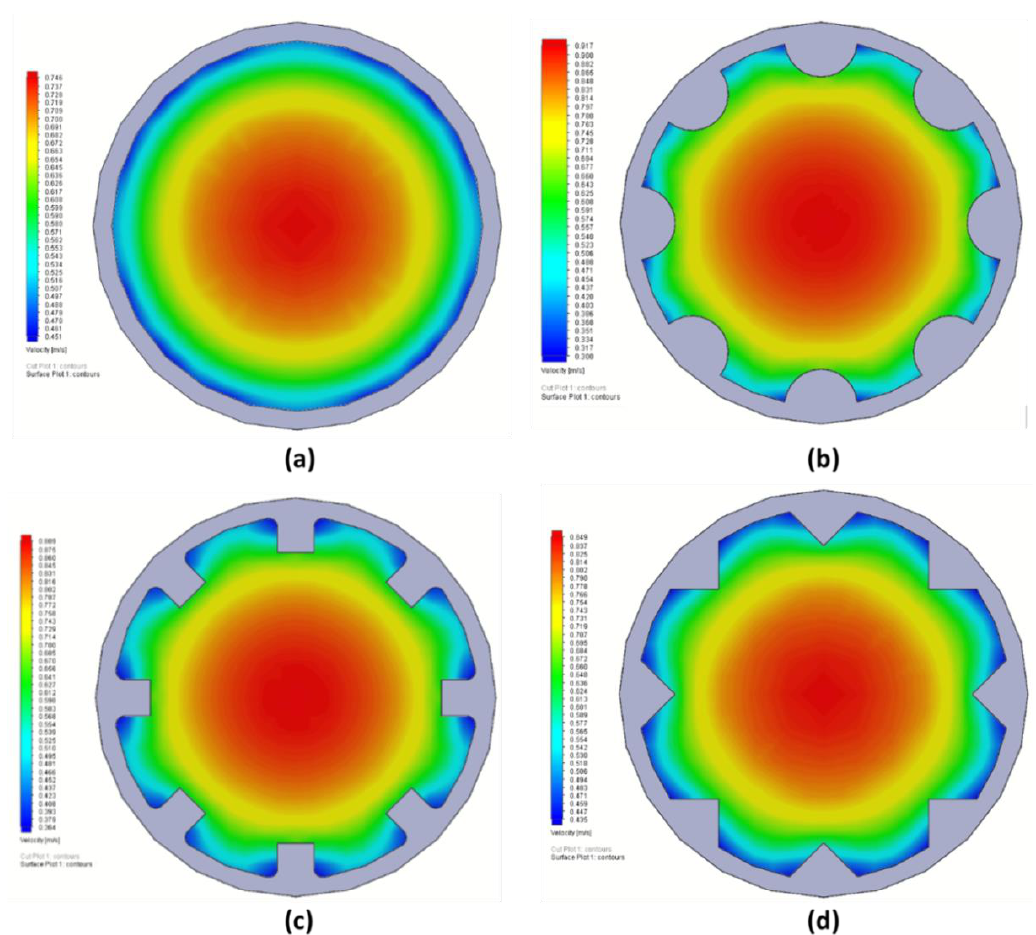
Figure 22. Fluid velocity in the outlet cross-section for the ( a ) reference empty tube [0.451 – 0.746 m/s], ( b ) tube with circular fins [0.300 – 0.917 m/s], ( c ) tube with rectangular fines [0.364 – 0.889 m/s], ( b ) tube with circular fins [0.300–0.917 m/s], ( c ) tube with rectangular fines [0.364–0.889 m/s], and ( d ) tube with triangular fins [0.435 – 0.849 m/s]. and ( d ) tube with triangular fins [0.435–0.849